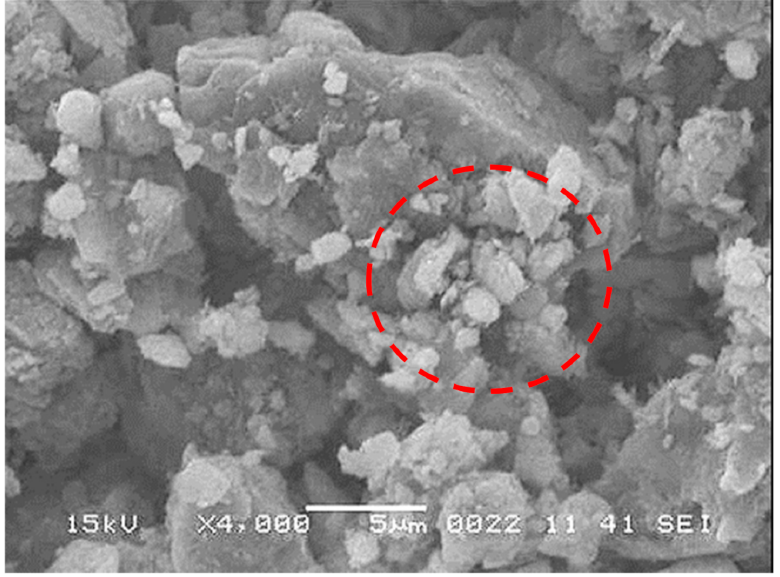
Figure 4. SEM Micro-image of dust particles. Dust particles have various shapes and sizes. Small dust particles adhere to large size particles forming clustering like structures as shown in the red dotted circle. The attachment of small particles demonstrates that these particles have increased polar